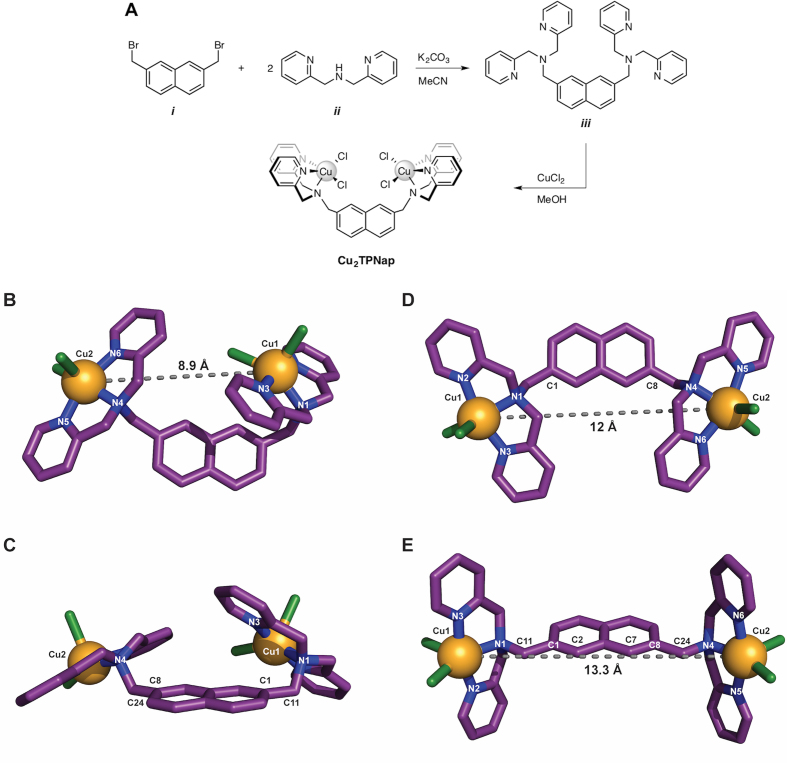
(A) Synthetic route toward generating the Cu2TPNap complex; (B) X-ray structure showing a perspective view of Cu2TPNap where copper ions are bridged by the naphthalene-methylamine group and the intermetal Cu•••Cu distance is 8.9 Å; (C) alternative perspective of Cu2TPNap; (D) rotation around methylamine bonds to their maximum dihedral angle of 180° resulting in a 12 Å intermetal distance and (E) further 180° rotation about methyl-naphthalene bonds yielding a maximum distance of 13.3 Å between Cu•••Cu centres. Figures B-E were generated using the PyMOL Molecular Graphics System, Version 2.0 Schrödinger, LLC. Colour scheme: copper, light orange; carbon, violet purple; nitrogen, deep blue; chloride, split pea.